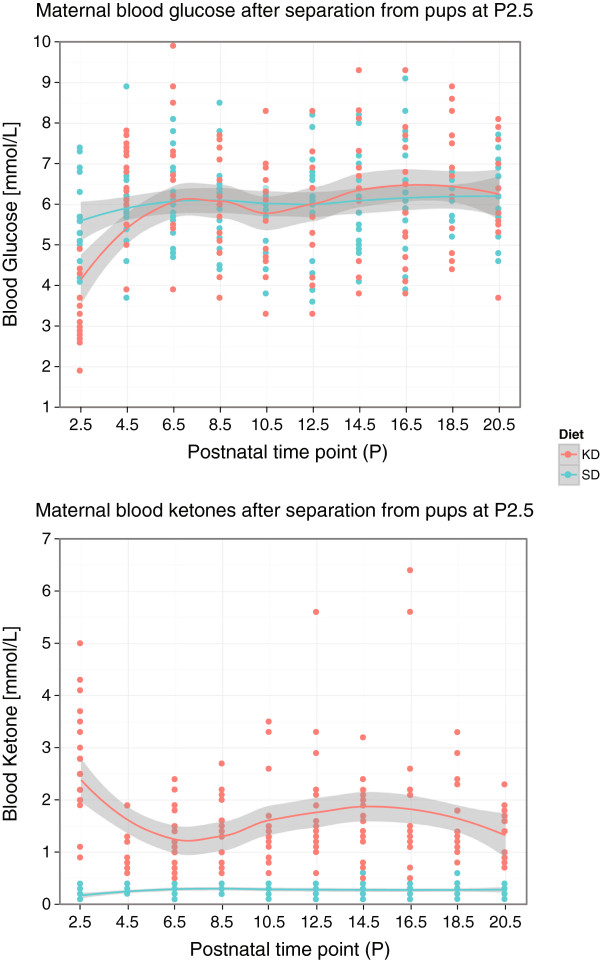
Blood glucose and ketone concentration over time in KD and SD dams following separation from their litters at P2.5, and until P20.5. Local regression is used to visualize trend, where the shaded region indicates the standard error. (NSD=19, NKD=17 per time point).